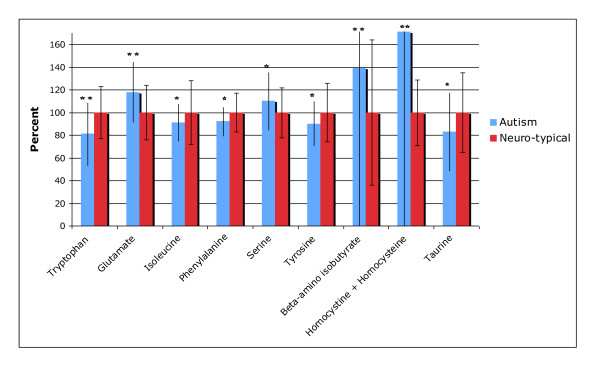
Amino Acids which were significantly different between the autism and neurotypical groups, rescaled to the average neurotypical value. The average values and the standard deviations are shown. The number of asterisks indicates the p-value (* p < 0.05, ** p < 0.01, *** p < 0.001). The standard deviations for beta-amino-isobutyrate and "homocystine + homocysteine" are outside the margins of the figure.